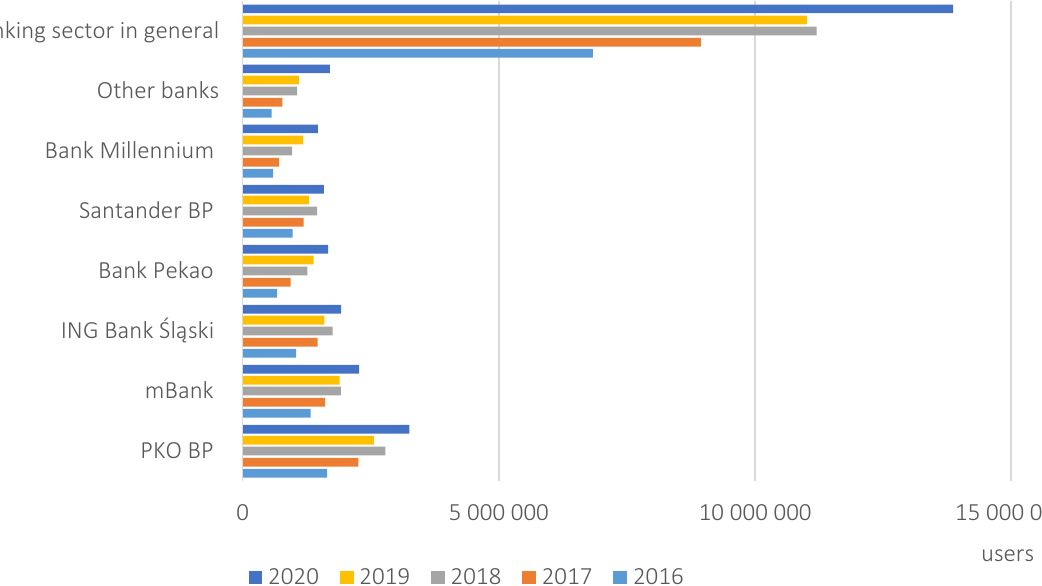
Figure 2. Dynamics of the number of users of mobile banking services in Poland in 2016–2020